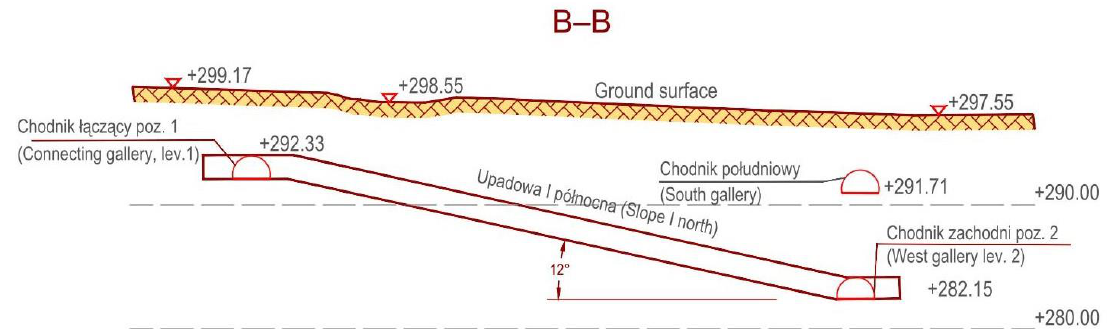
Figure 3. The cross-section B–B.